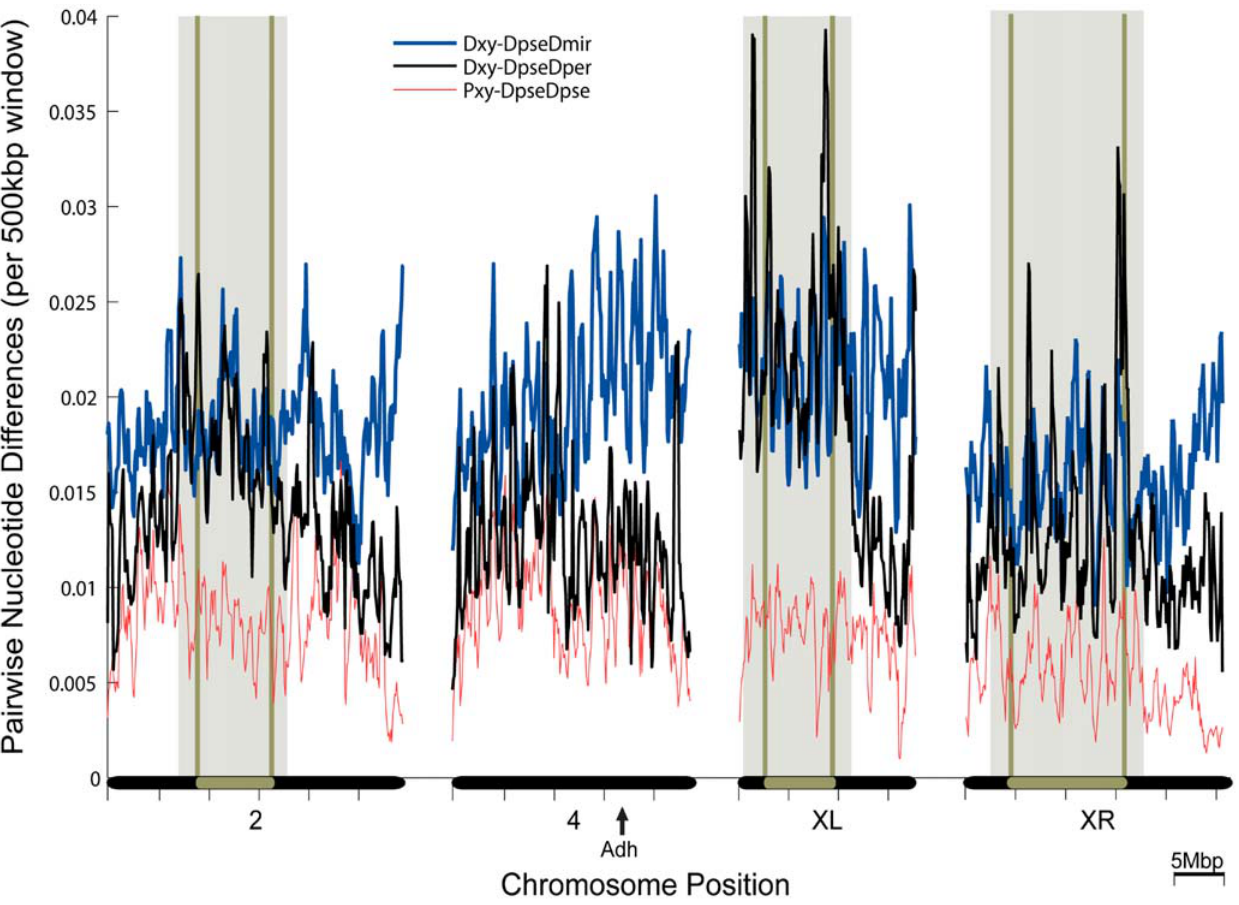
Figure 1. Genome-wide distribution of variation. Divergence (Dxy) between the D. pseudoobscura ( Dpse ) and each of D. persimilis ( Dper , black line) and D. miranda ( Dmir , blue line) is estimated in overlapping 500 kbp windows (100 kbp steps) across chromosome arms 2, 4, XL, and XR. All chromosome arms are presented from the telomere to centromere (left-to-right), though the sequence assemblies start well outside both the telomere and centromere in each case. Nucleotide diversity (Pxy) is estimated as the pairwise differences between genomic sequences of two strains of D. ps. pseudoobscura (red line). The breakpoints of the inversions distinguishing D. ps. pseudoobscura and D. persimilis are superimposed on each chromosome (rounded brown rectangle) and on the graph (vertical brown lines). The region where recombination is suppressed in hybrids is boxed in gray. Contigs from chromosomes are oriented and ordered according to previous studies. Each chromosomal increment is 5 Mbp. The positive control locus, Adh , is highlighted on chromosome 4 group